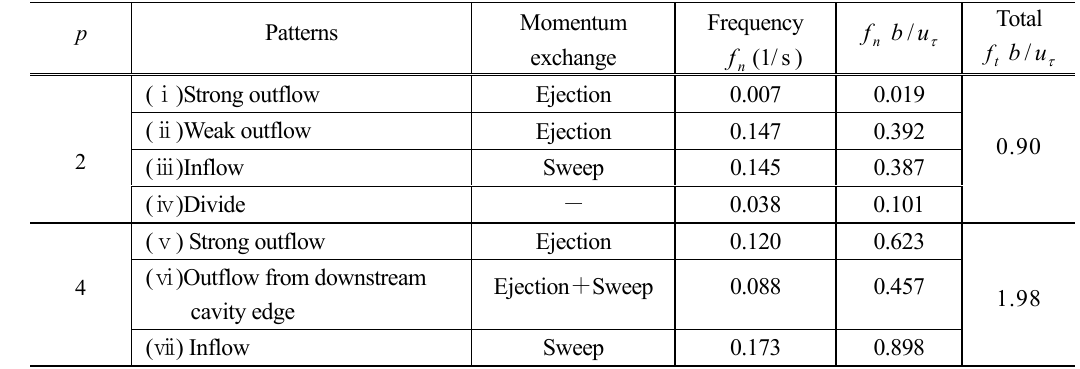
Table 2 Frequency on each